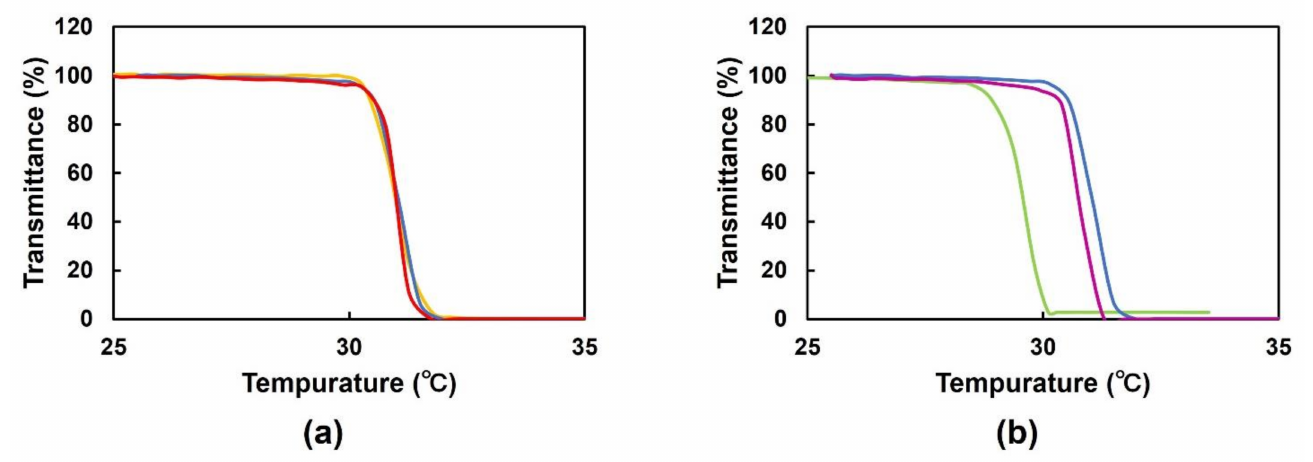
Figure 4. Transmittance of the BSA-PNIPAAm solutions against temperature (thermal-response): ( a ) Monomer ratio to CTA. B/C5/PN400 (yellow), B/C5/PN800 (blue), B/C5/PN1600 (red). ( b ) CTA ratio to BSA. B/C2/PN800 (green), B/C5/PN800 (blue), B/C10/PN800 (purple). (solvent: PBS (pH: 7.4), BSA concentration: 1.0 mg/mL, heating rate: 1 ◦ C/min, wavelength: 450 nm).